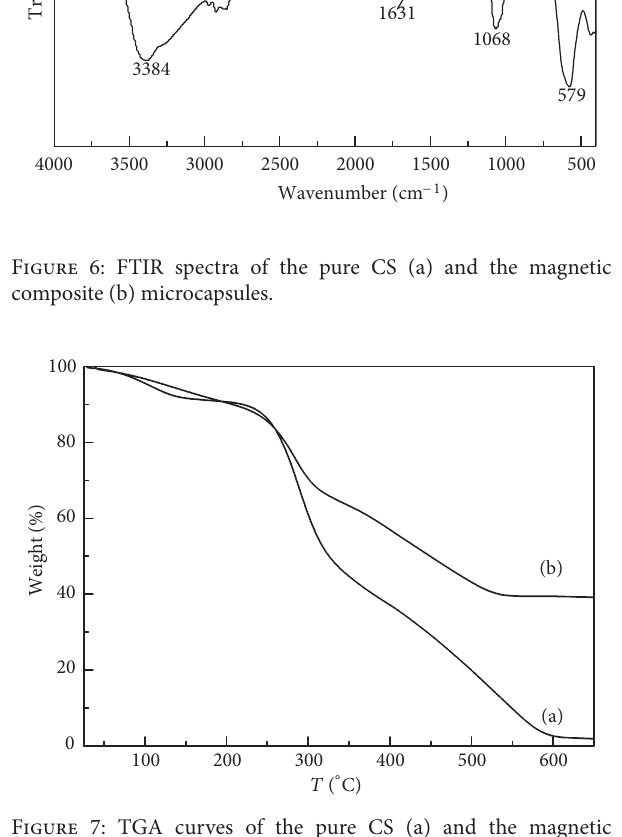
F 7: TGA curves of the pure CS (a) and the magnetic composite (b)